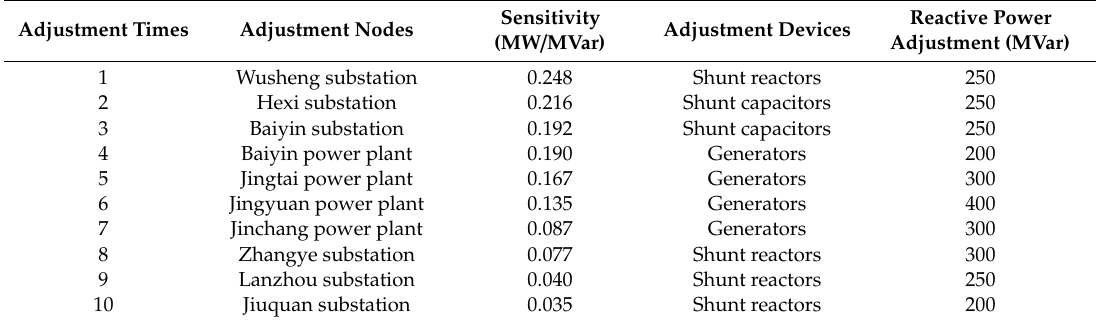
Table 3. Whole process of reactive power adjustment.